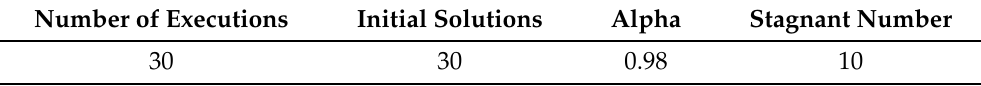
Table 3. General parameters for